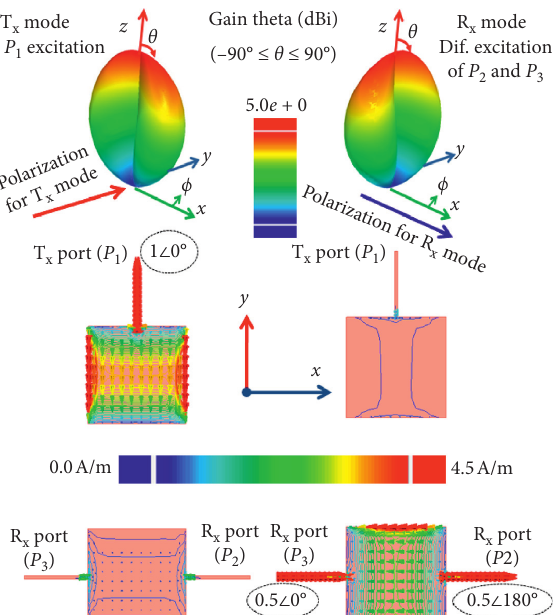
Figure 5: The simulated surface currents intensity and 3D gain patterns at f � 2.4GHz for T respective port excitation.